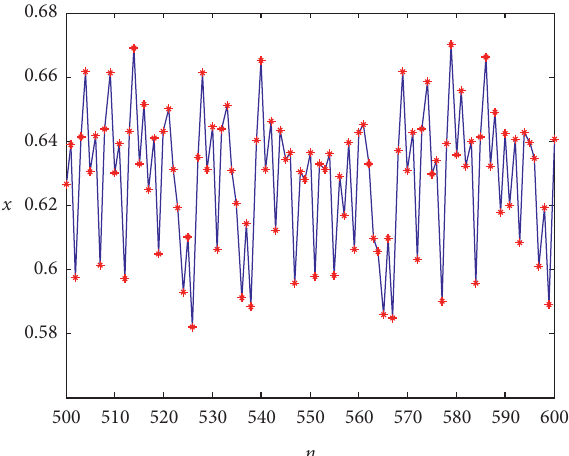
Figure 24: x - n sequence diagram which denotes that the system is chaotic when c � 0.8.